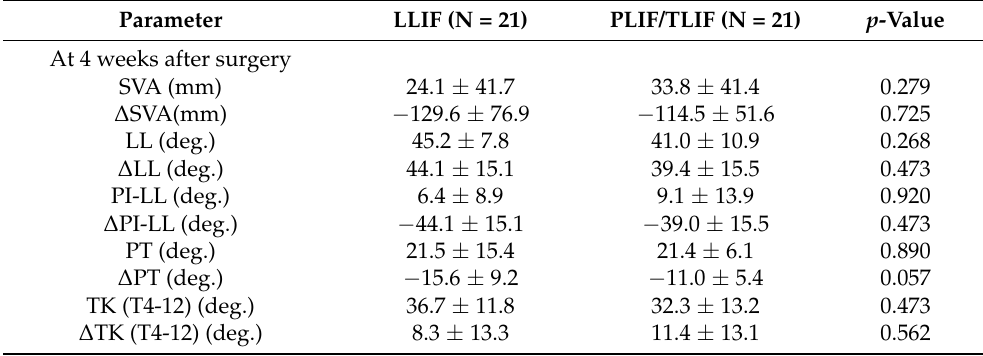
Table 3. The comparison of the LLIF group and the PLIF/TLIF group for radiographic parameters at each follow-up